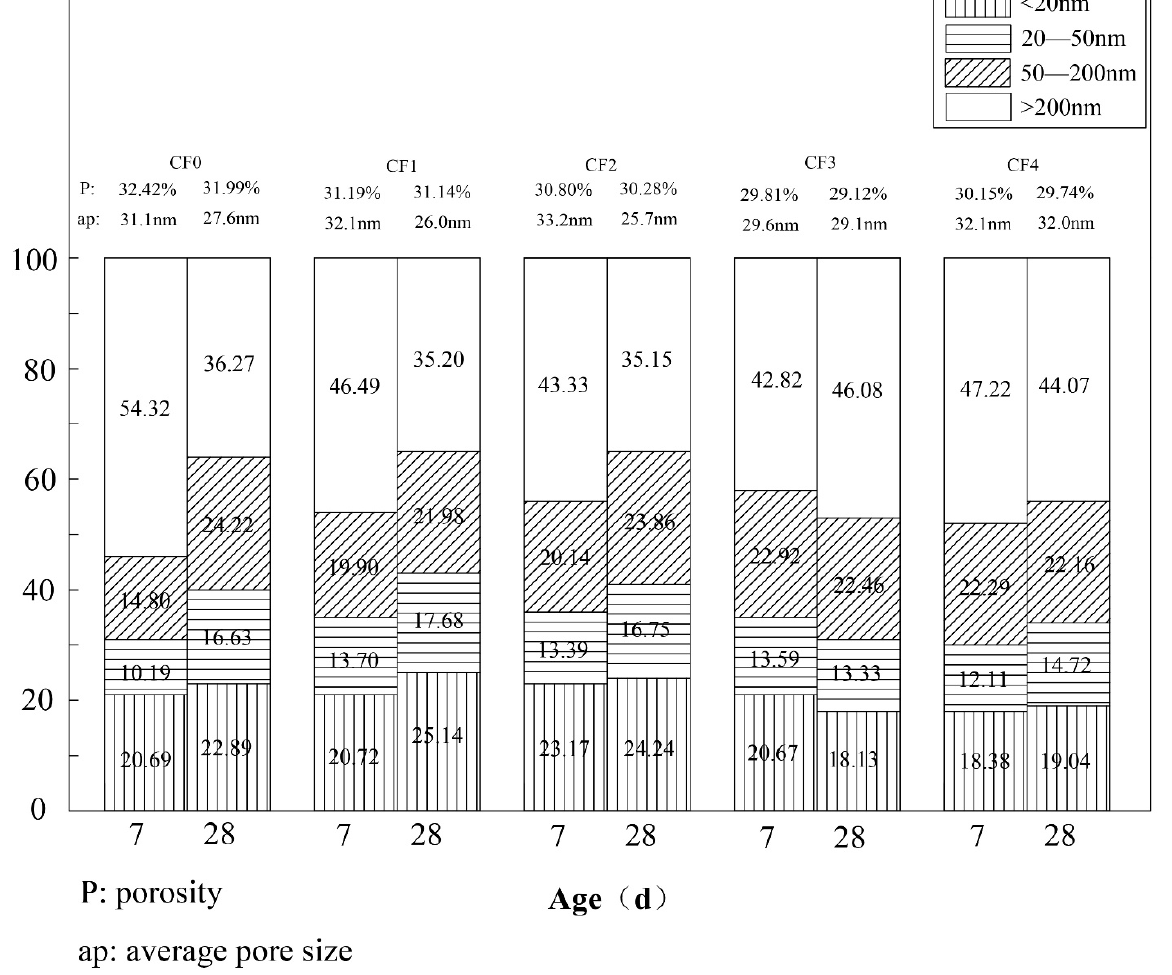
Figure 10. Distribution of pore structure of fly-ash-modified CSM with 100% RMA.